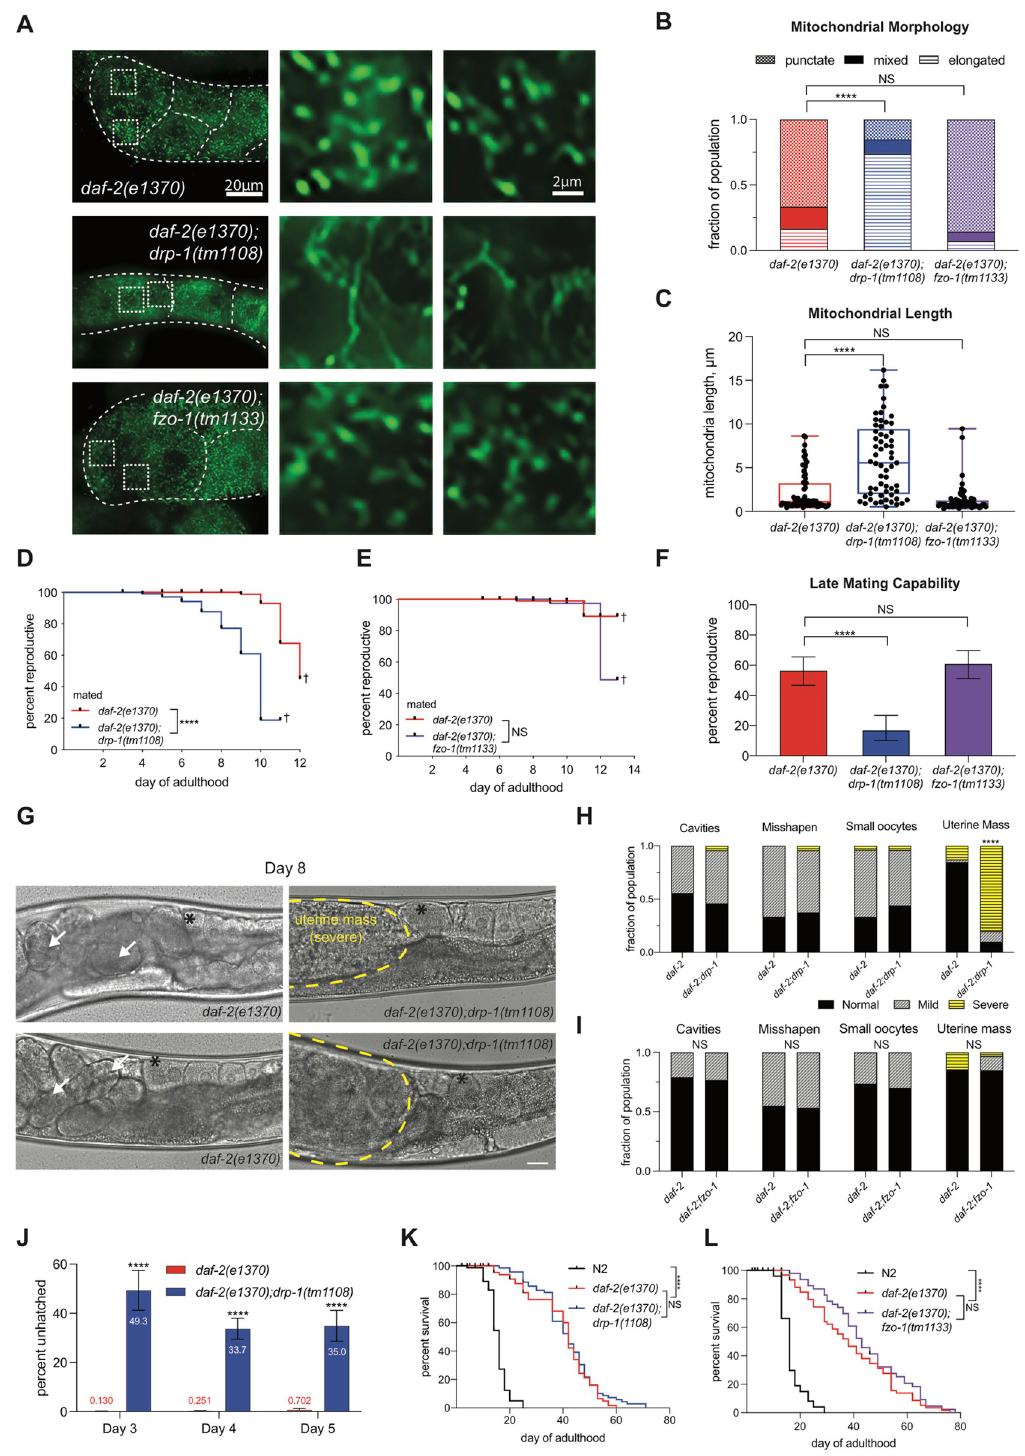
Fig 3. daf-2 requires fission, not fusion, for reproductive longevity. (A) Representative images of Day 4 adult mitochondrial morphology in the -1 oocyte marked with anti-ATP5 α . White-dotted boxes are enlarged (right) of the morphology in the -1 oocyte (I and II). Scale bar 10 μ m. Images in A were processed using the same parameters across the entire image (i.e. adjusting for brightness and contrast). (B) Blind scoring results of mitochondrial morphology of the -1 oocyte in three categories: punctate, mixed, or elongated of daf-2(e1370) (n = 30), daf-2(e1370);drp-1(tm1108) (n = 46), and